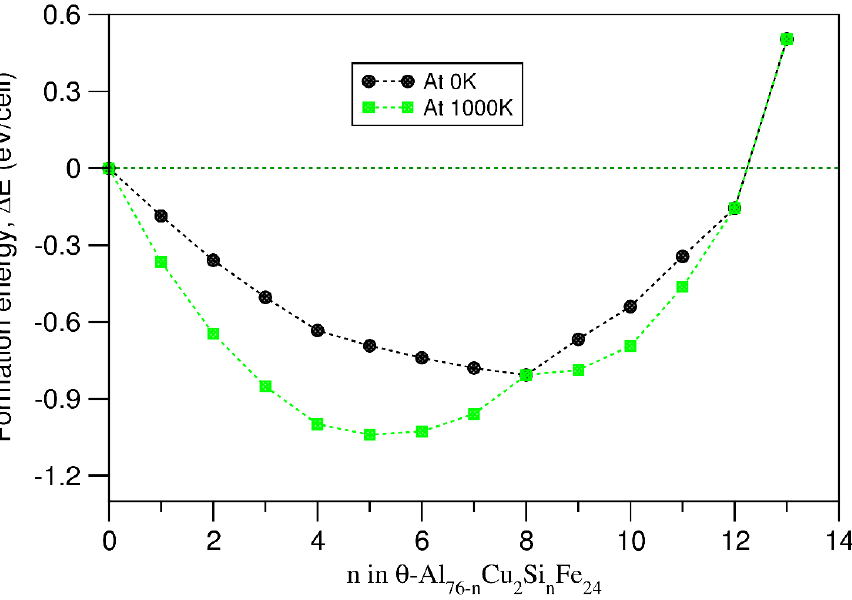
Figure 6. The relation between the assessed formation energy at 1000 K and the Si content using the random model for Si at Al8 and Al9 sites when n < 8 and at Al6 when - n > 8. The related lowest formation energies at 0 K are included for